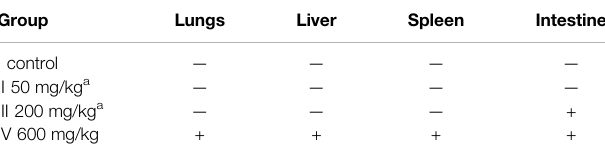
TABLE 1 | Histological abnormalities of internal organs (+) in CBA mice treated with 7-MG. Group Lungs Liver